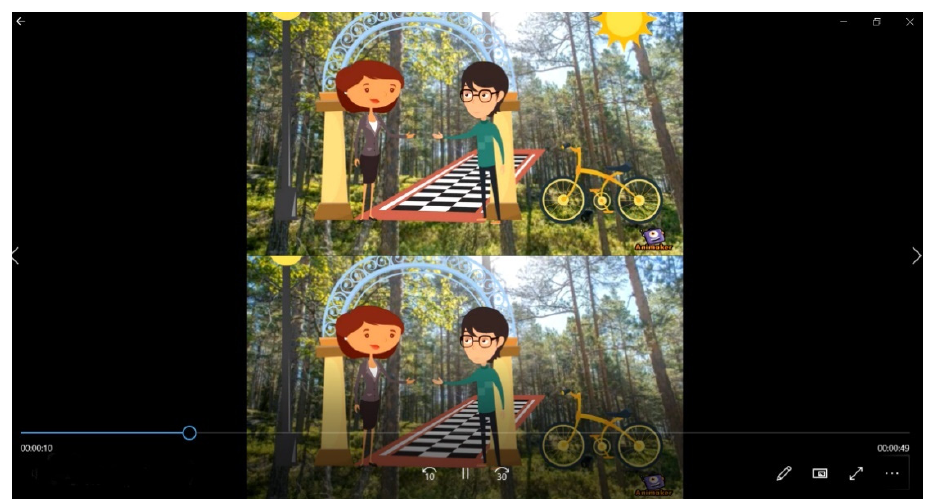
Figure 2. A frame of animation video with a background and with a top-to-bottom arrangement.